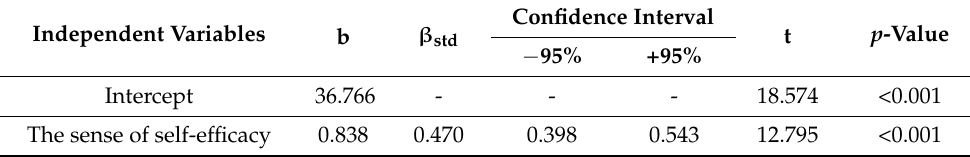
Table 2. The influence of the sense of one’s own efficacy on authentic leadership